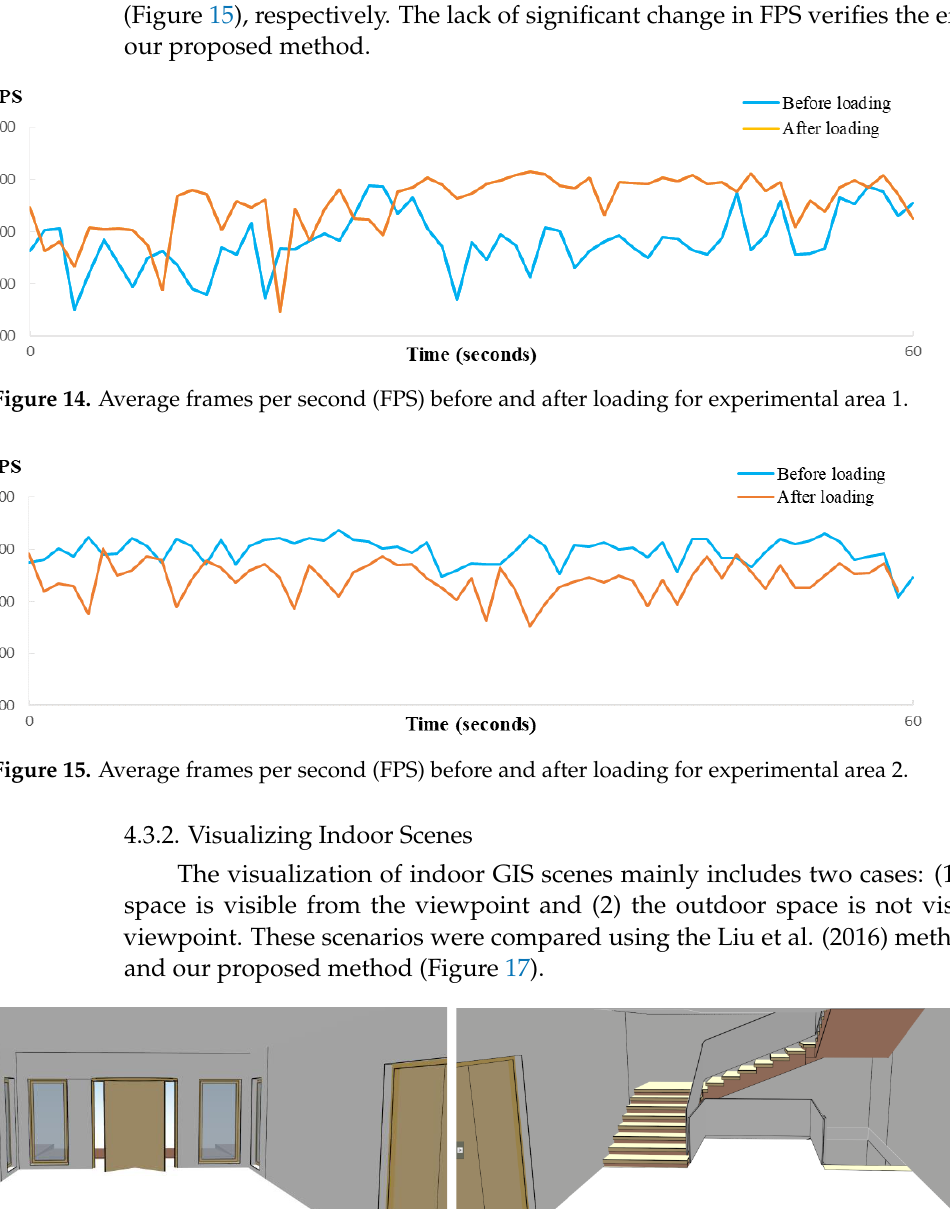
Table 4. Statistical results for the experimental test.